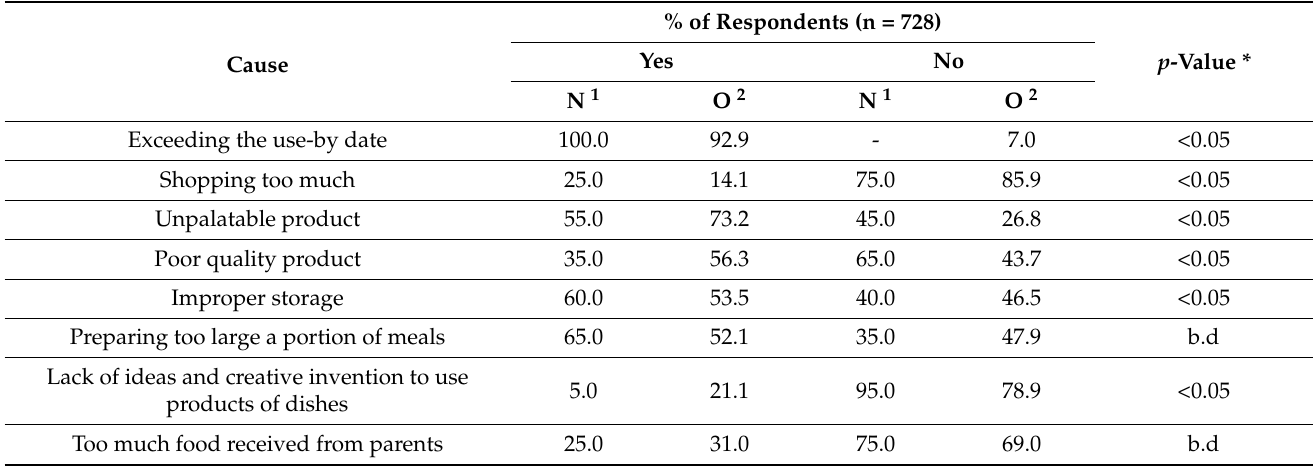
Table 3. Causes of food waste among